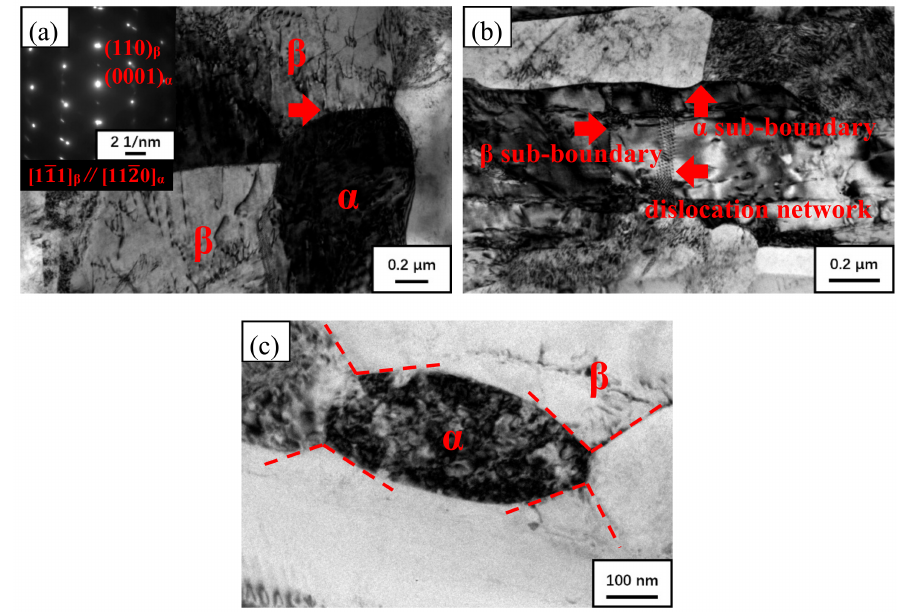
Figure 8. TEM graphs of microstructure evolution with the Burgers orientation relationship between the neighboring β and α ; ( a ) slip transmission of dislocations at the α / β interface at the strain of 0.1, ( b ) formation of substructure in α and β at the strain of 0.4, and ( c ) hedging of the β phase into the acicular α phase along the α / α